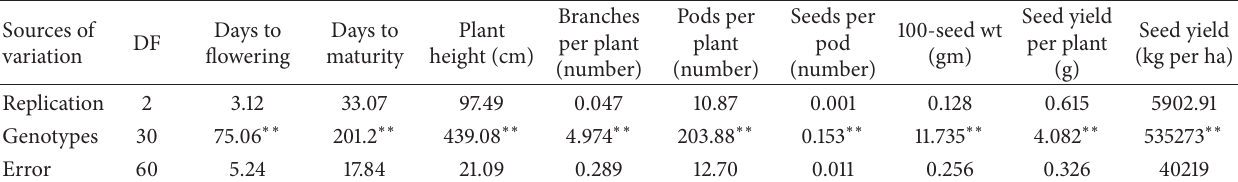
Table 3: Mean square values for nine different phenological and morphological characters, yield attributes, and seed yield among 31 soybean